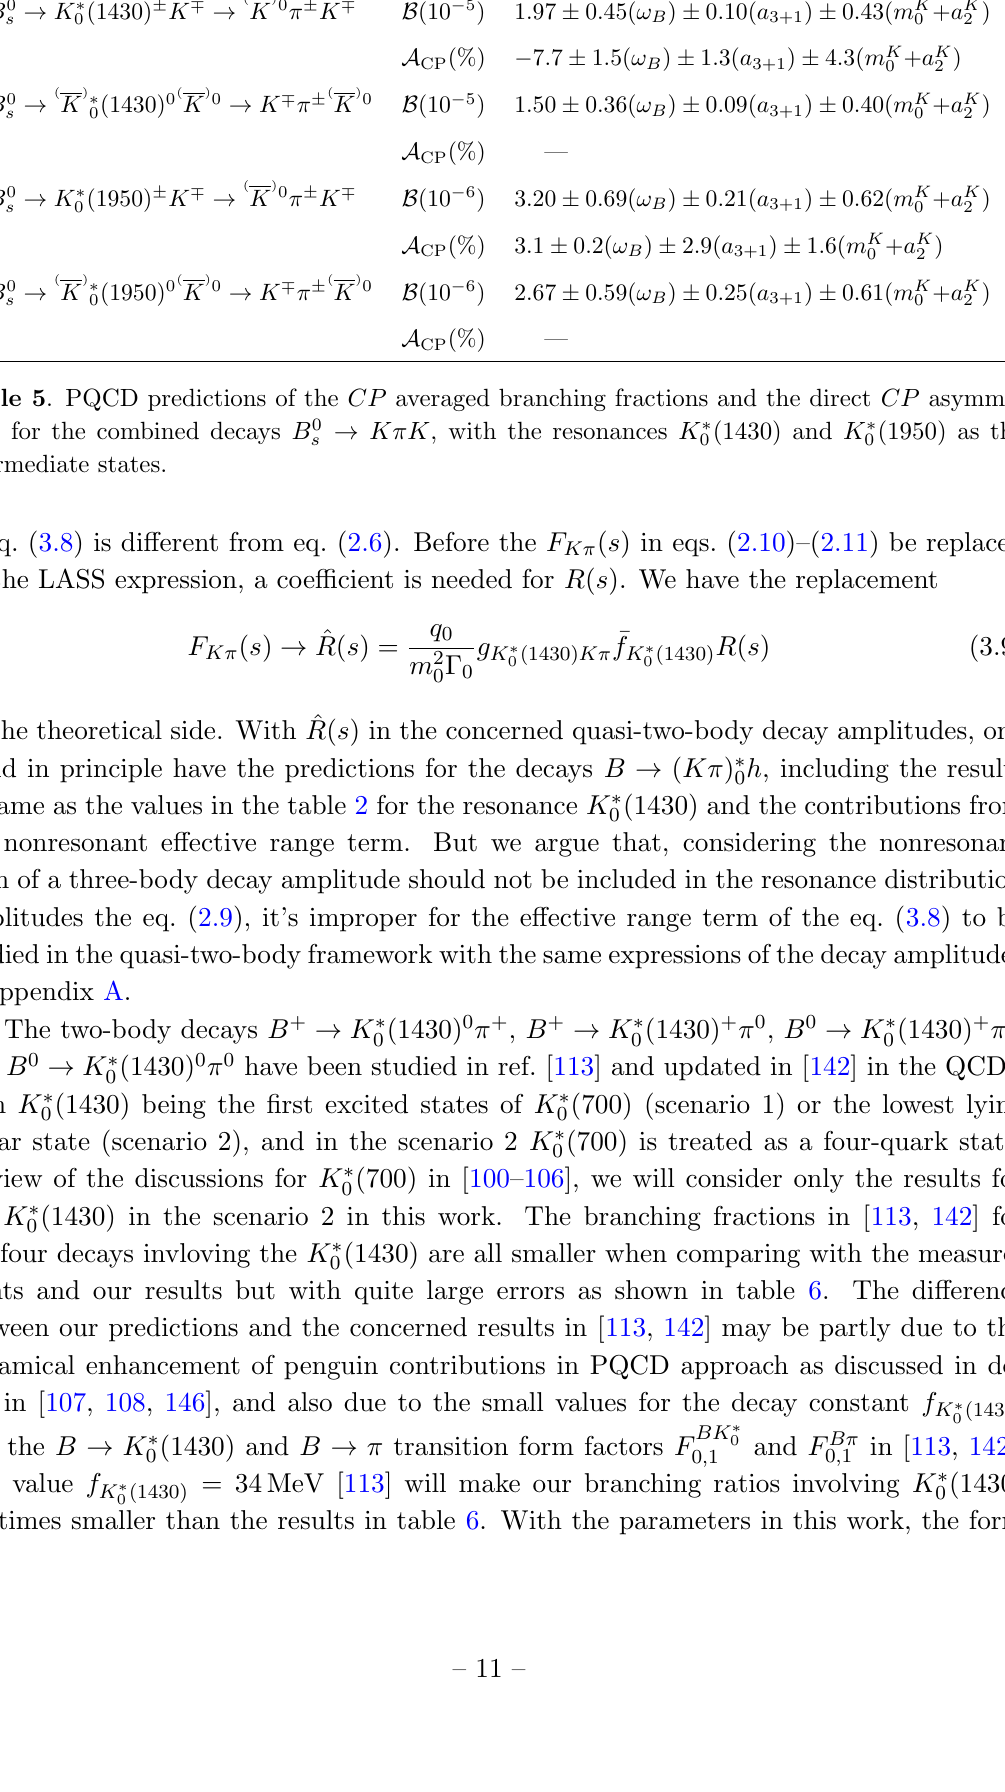
! K(cid:25)K , with the resonances K (cid:3) s